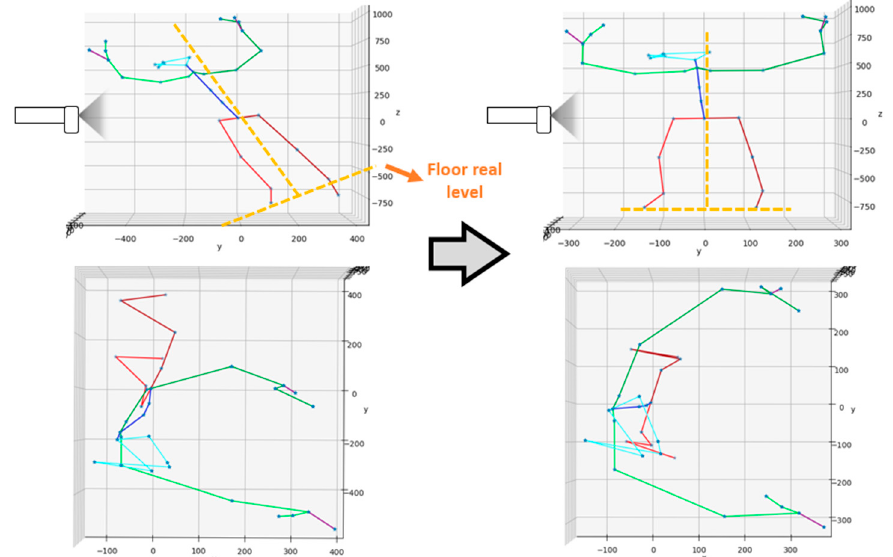
Figure 7. Step 3: Pitch and roll angles correction.